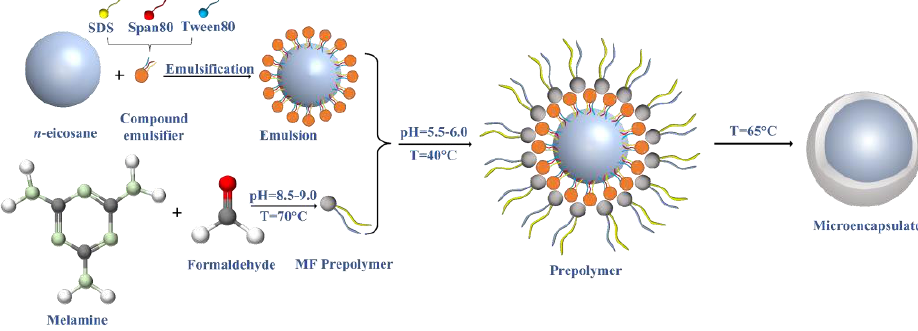
Figure 1. Schematic diagram of the preparation of MPCM.